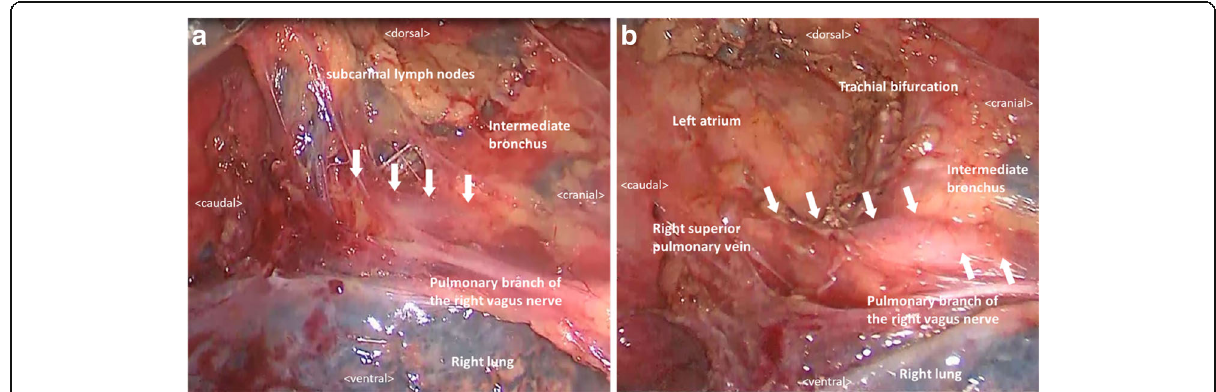
Fig. 4 Intraoperative findings. a The anomalous V2 identified during the subcarinal lymph node dissection (white arrow). The right bronchus is rolled by pulling the pulmonary branch of the right vagus nerve toward the right side. b The anomalous V2 preserved after the dissection (white arrow)